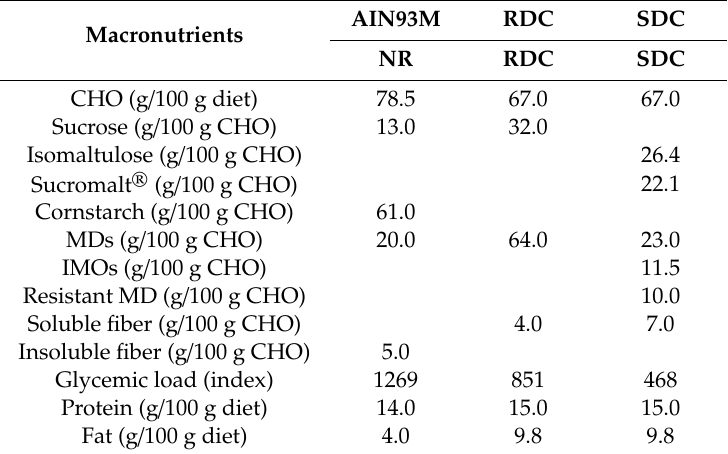
Table 1. Composition of diets used in this